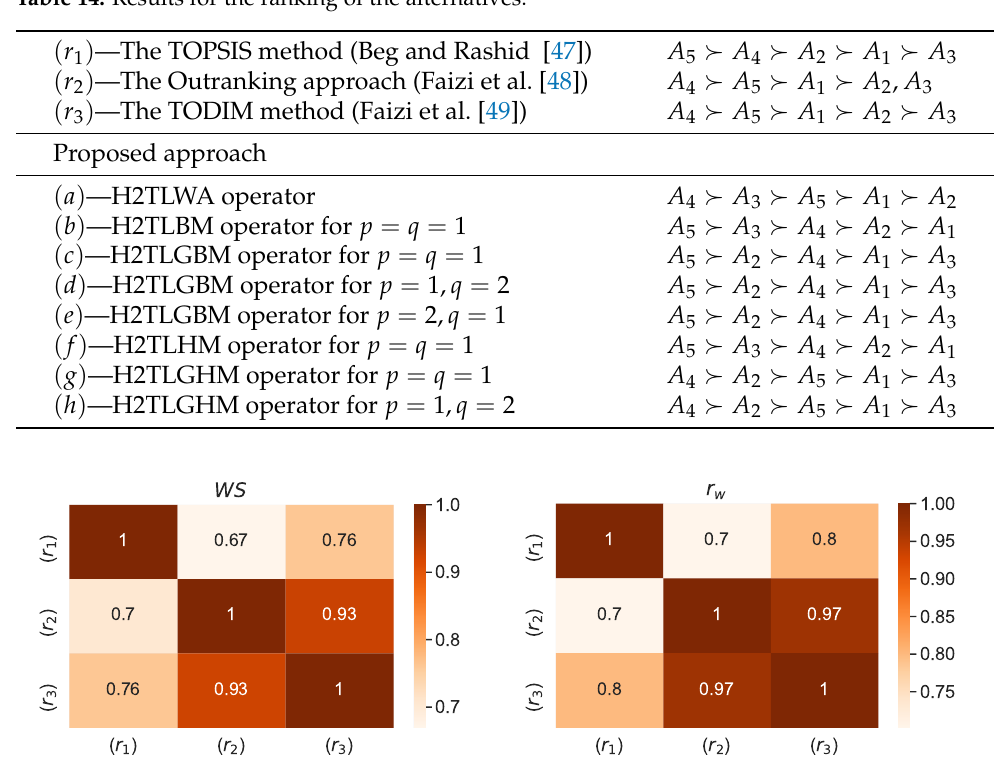
Table 14. Results for the ranking of the alternatives.